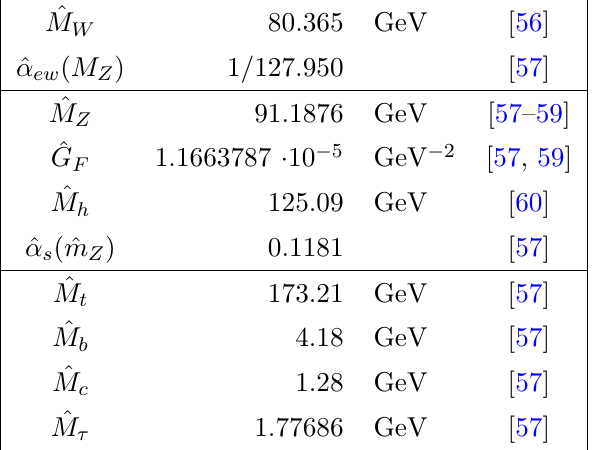
Table 1 . Numerical central values of the relevant SM parameters used as inputs for the estimate of the leading SMEFT corrections. Only one among the values of ^ M W and ^ (cid:11) ew is used as input, depending on the scheme adopted. All the other parameters are common to the two input schemes